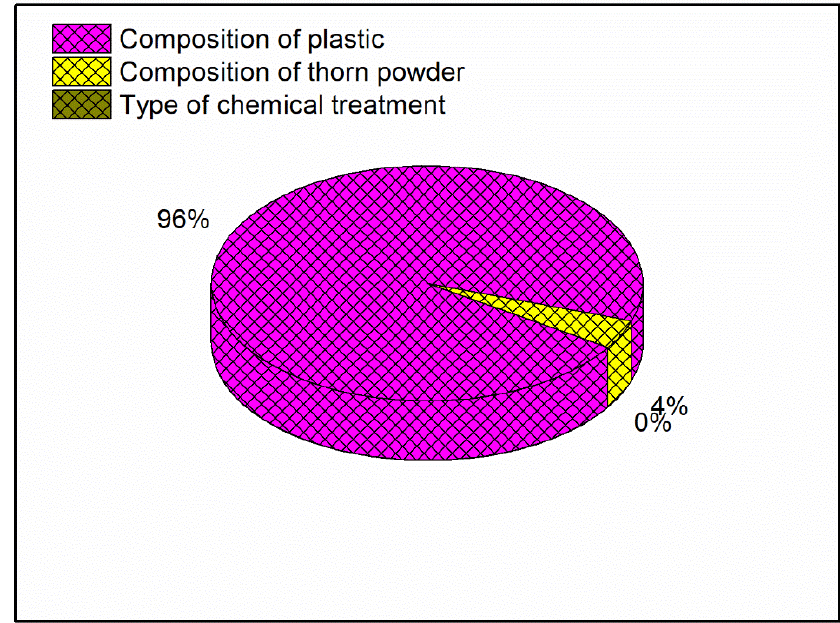
Figure 13. Contribution plot for Maximum tensile strength. Table 5. Tensile strength results from